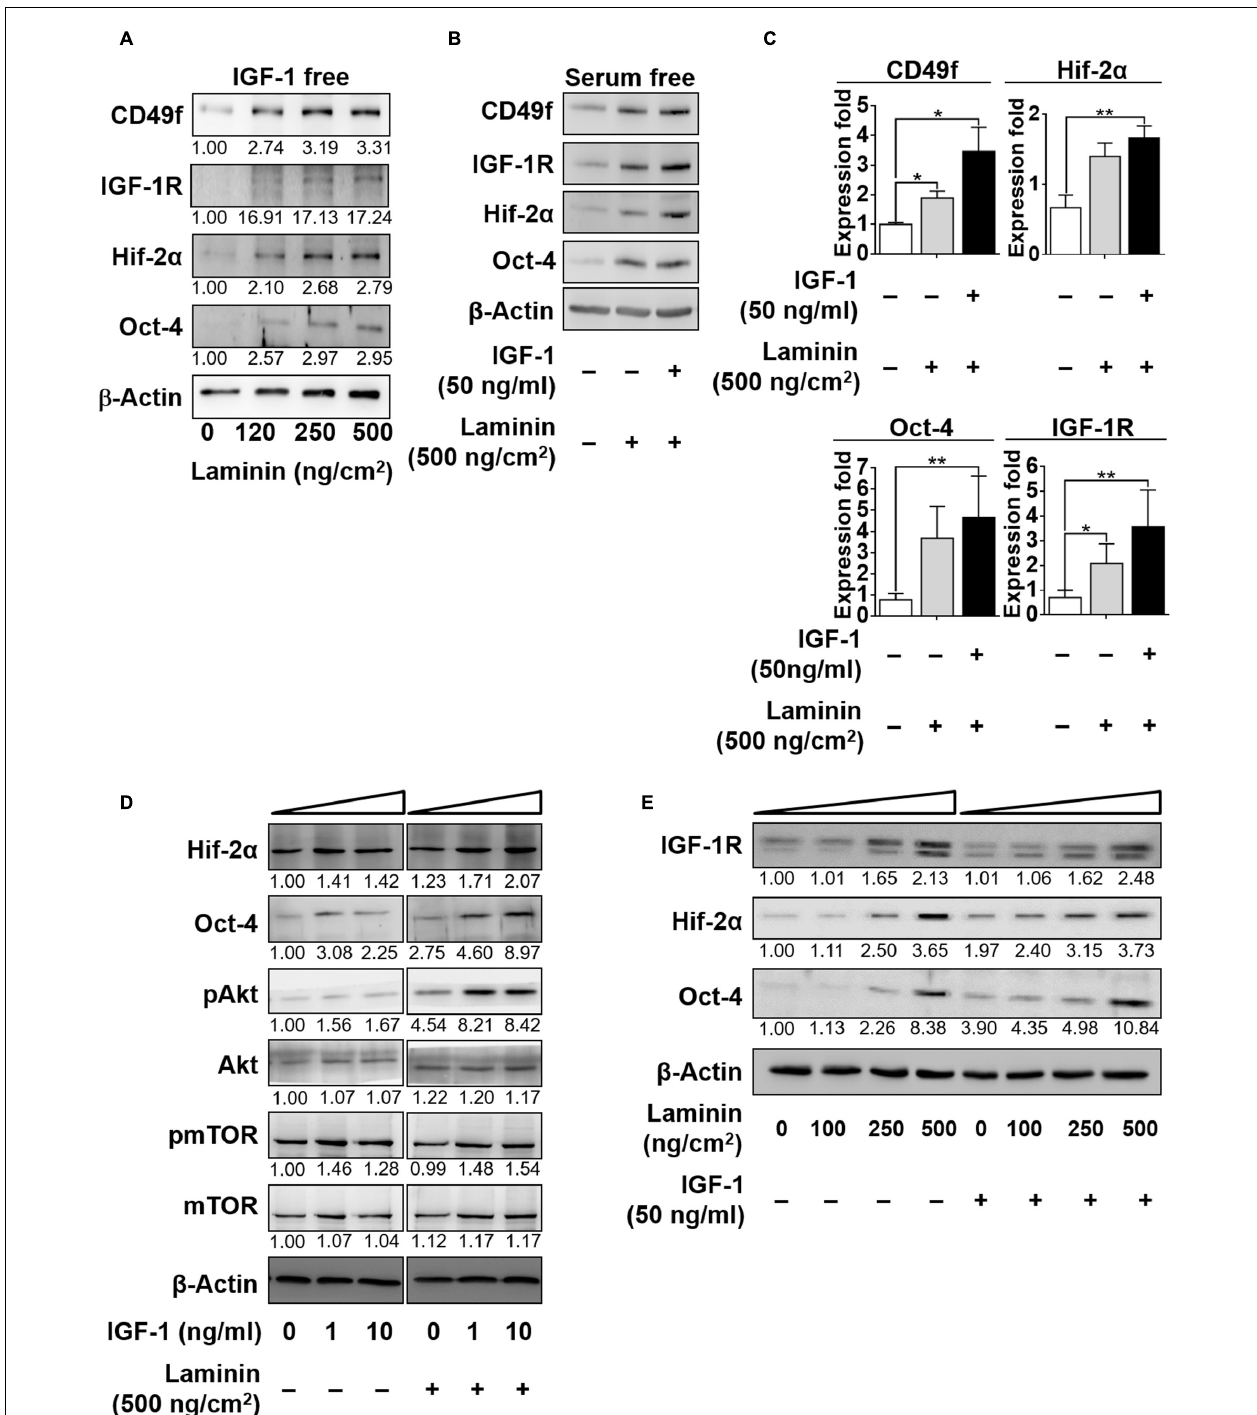
FIGURE 3 | IGF-1 and laminin act additively to increase the expression of CD49f, IGF-1R, Hif-2 α , and Oct-4 in CD49f + AP + GSCs. (A) Dose-dependent effects of laminin (0, 120, 250, and 500 ng/cm 2 ) on the protein expression of CD49f, IGF-1R, Hif-2 α and Oct-4 in CD49f + AP + GSCs in the absence of IGF-1. (B) Effects of laminin (500 ng/cm 2 ) with or without IGF-1 (50 ng/ml) treatment on the expressions of IGF-1R, CD49f, Hif-2 α , and Oct-4. (C) Quantitative and statistical analysis of the effects on (B) . Data are means ± SEM of at least three independent experiments. * p < 0.05; ** p < 0.01 (one-way ANOVA). (D) Dose-dependent effects of IGF-1 (0, 1, and 10 ng/ml) with or without laminin (500 ng/cm 2 ) treatment on the protein expression of Hif-2 α , Oct-4, and on the Akt-mTOR signaling. (E) Dose-dependent effects of laminin (0, 100, 250, and 500 ng/cm 2 ) with or without IGF-1 (50 ng/ml) treatment on the expression of IGF-1R, Hif-2 α , and Oct-4. The relative quantification was normalized to the corresponding β